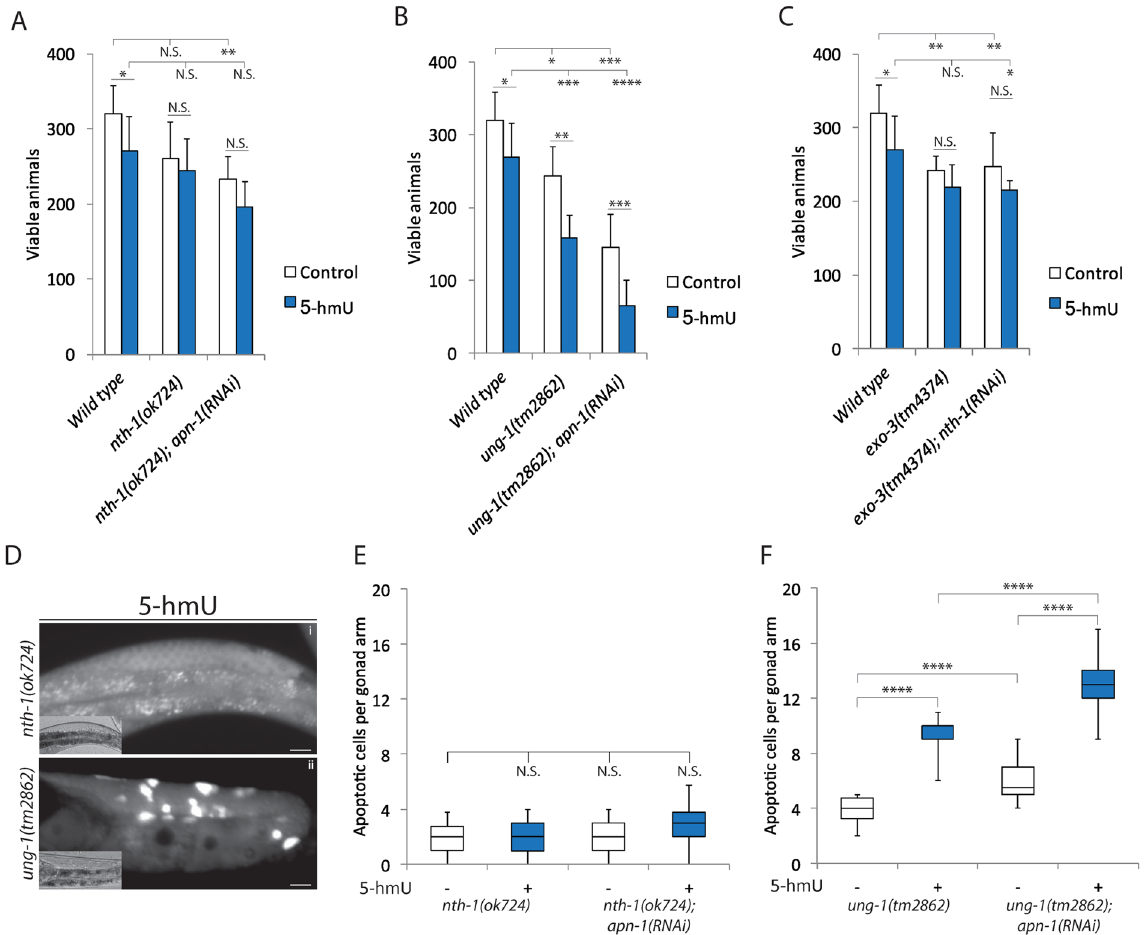
Figure 5. . ung-1 , but not nth-1 , mutants are sensitive to the genotoxic effects of 5-hmU. ( A , B and C ) Control and 5-hmU-treated animals for analysis of brood size as described in Fig. 1B–D. The data are the mean ± S.D. of three independent experiments ( n = 10 monitored for 3 days). Error bars represent the S.D. Unpaired two- tail t-test *** P < 0.01; **** P < 0.0005 were considered to be statistically significant. N.S. = Non-Significant. ( A ) Control; Wild type: 319 ± 38; nth-1(ok724) : 260 ± 48; nth-1(ok724); apn1(RNAi) : 232 ± 30, and exposure to 5-hmU; Wild type: 269 ± 46; nth-1(ok724) : 244 ± 42; nth-1(ok724); apn1(RNAi) : 195 ± 33. ( B ) Control; Wild type: 319 ± 38; ung-1(tm2862) : 244 ± 39; ung-1(tm2862); apn1(RNAi) : 146 ± 45 and exposure to 5-hmU; Wild type: 269 ± 46; ung-1(tm2862) : 157 ± 32; ung-1(tm2862); apn1(RNAi) : 65 ± 35. ( C ) Control; Wild type: 319 ± 38; exo-3(tm4374) : 241 ± 19; exo-3(tm4374); nth-1(RNAi) : 247 ± 45 and exposure to 5-hmU; Wild type: 269 ± 46; exo-3(tm4374) : 219 ± 30; exo-3(tm4374); nth-1(RNAi) : 215 ± 12. ( D) , Representative images of acridine orange-stained and DIC (lower left) of 5-hmU treated nth-1(ok724) and ung-1(tm2862) mutant animals as described in Fig. 2B. ( E , F ) Box and whisker plots showing quantification of apoptotic corpses from control and 5-hmU-treated of ( E ) nth-1(ok724) and ( F) ung-1(tm2862) mutant animals and scored as in Fig.